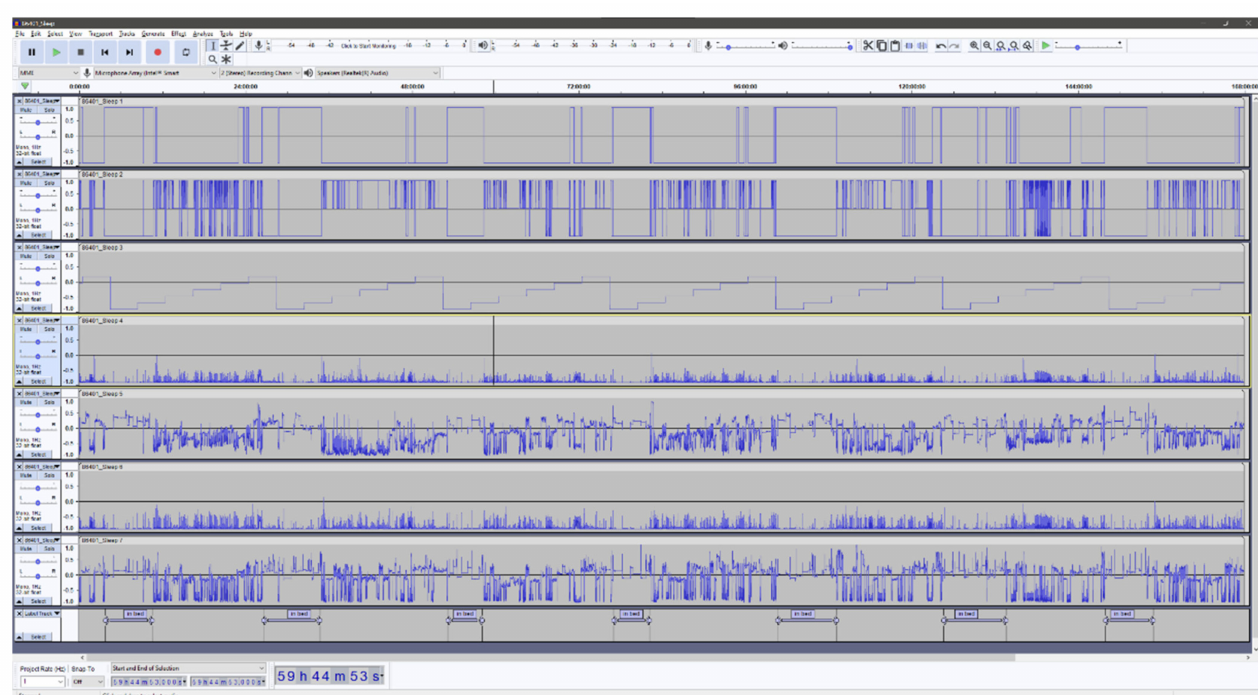
Figure 1. Screenshot of the Audacity interface showing the seven horizontal panels representing the included signal features. See Table 1 for a detailed description of the